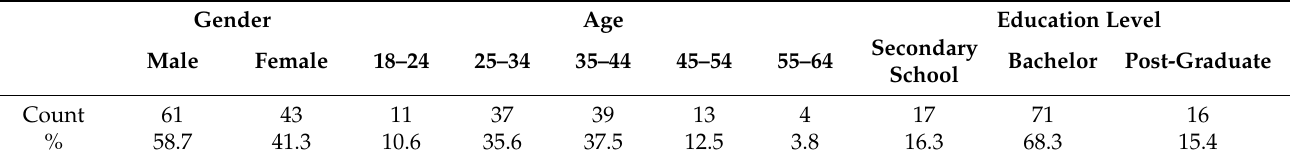
Table 1. Participant